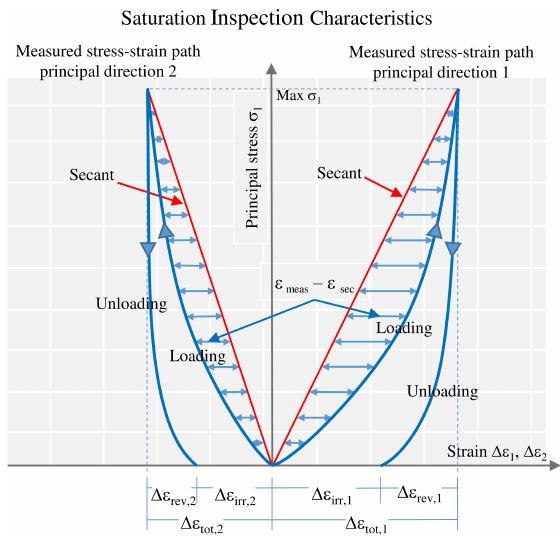
Figure 1. Saturation inspection characteristics, illustrated at normalized stress–strain paths in principal directions 1 and